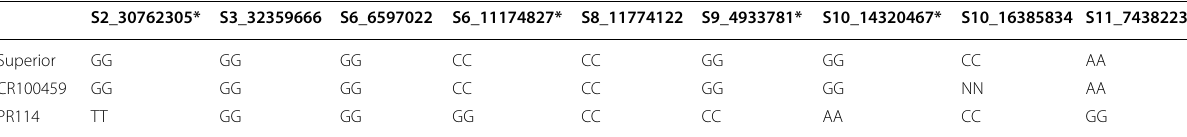
Table 9 The list of O. rufipogon accessions possessing combination of superior alleles at significant SNP positions associated with PL where SNPs marked with * represent alleles absent in indica